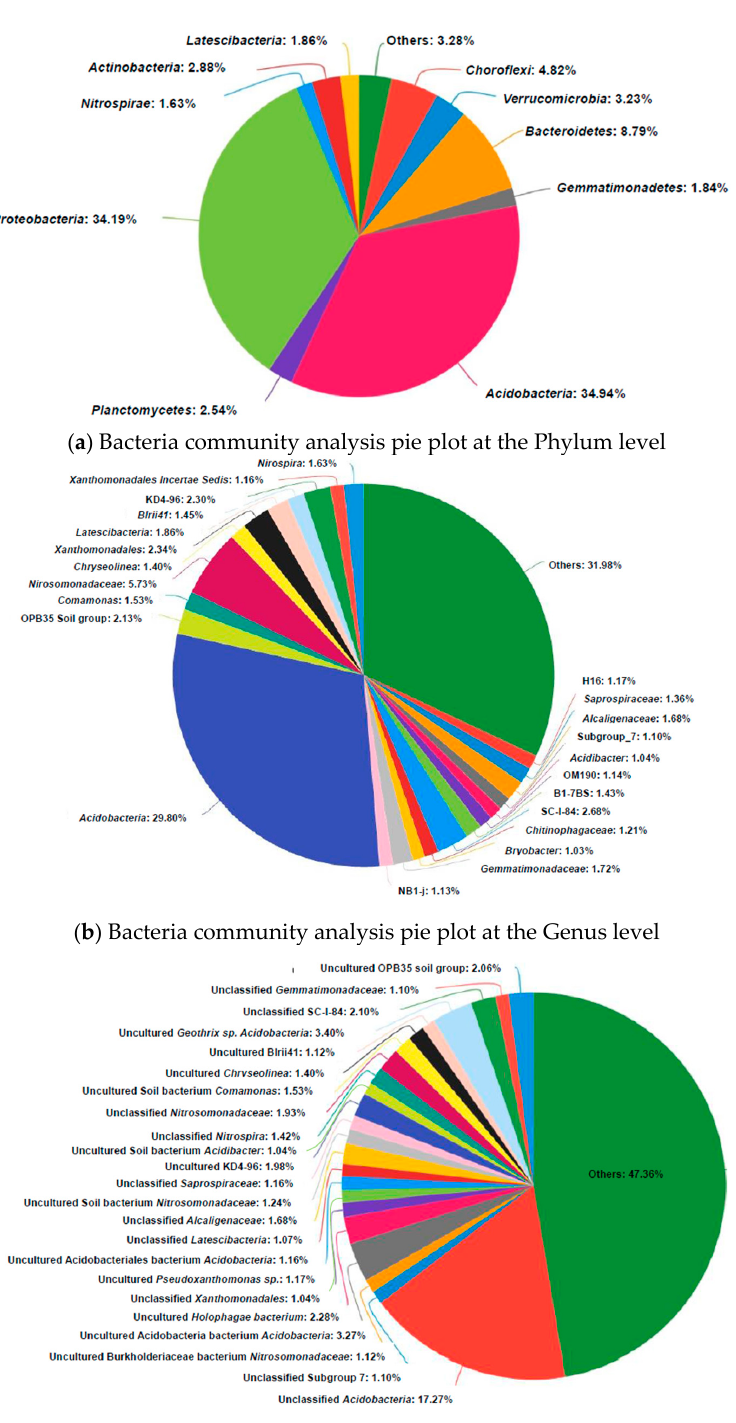
Figure 6. Bacteria community analysis pie plot at the Phylum ( a ), Genus ( b ) and Species ( c ) level sampled from rhizosphere of the experimental plant. Genera making up less than 1% of the total composition are defined as “others”.